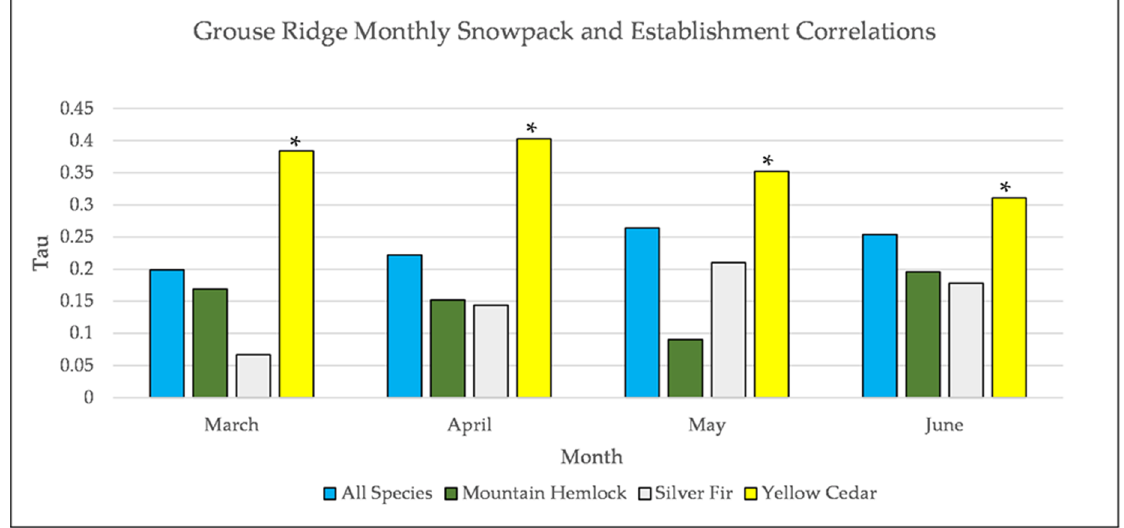
Figure A15. Partial Kendall’s correlation controlled for temperature between snowpack and establishment at Grouse Ridge. * = p -Value < 0.05. July is not included for snowpack at Grouse Ridge because there is rarely any snowpack at Grouse Ridge in July.